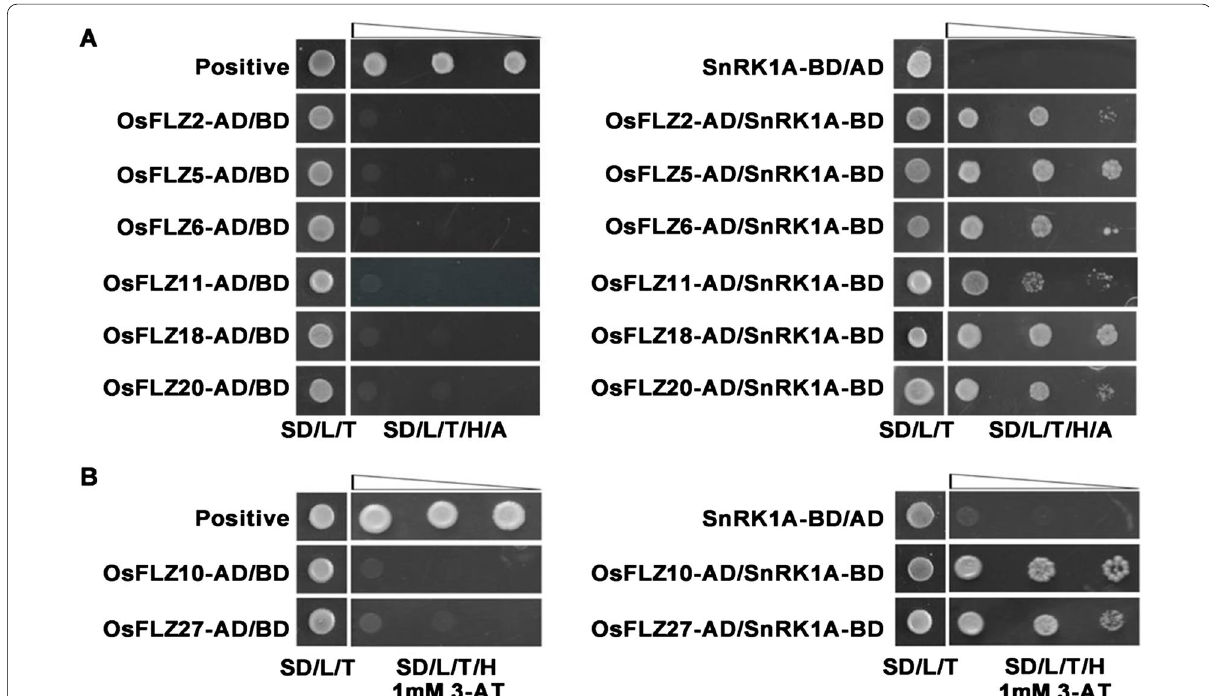
Fig. 4 OsFLZs interact with SnRK1A in yeast. OsFLZs were fused to the activation domain, and rice SnRK1A was fused to the DNA-binding domain, respectively. Co-transformed yeast clones were serial diluted and then assessed on SD/–Leu–Trp–His-Ade ( a ) or